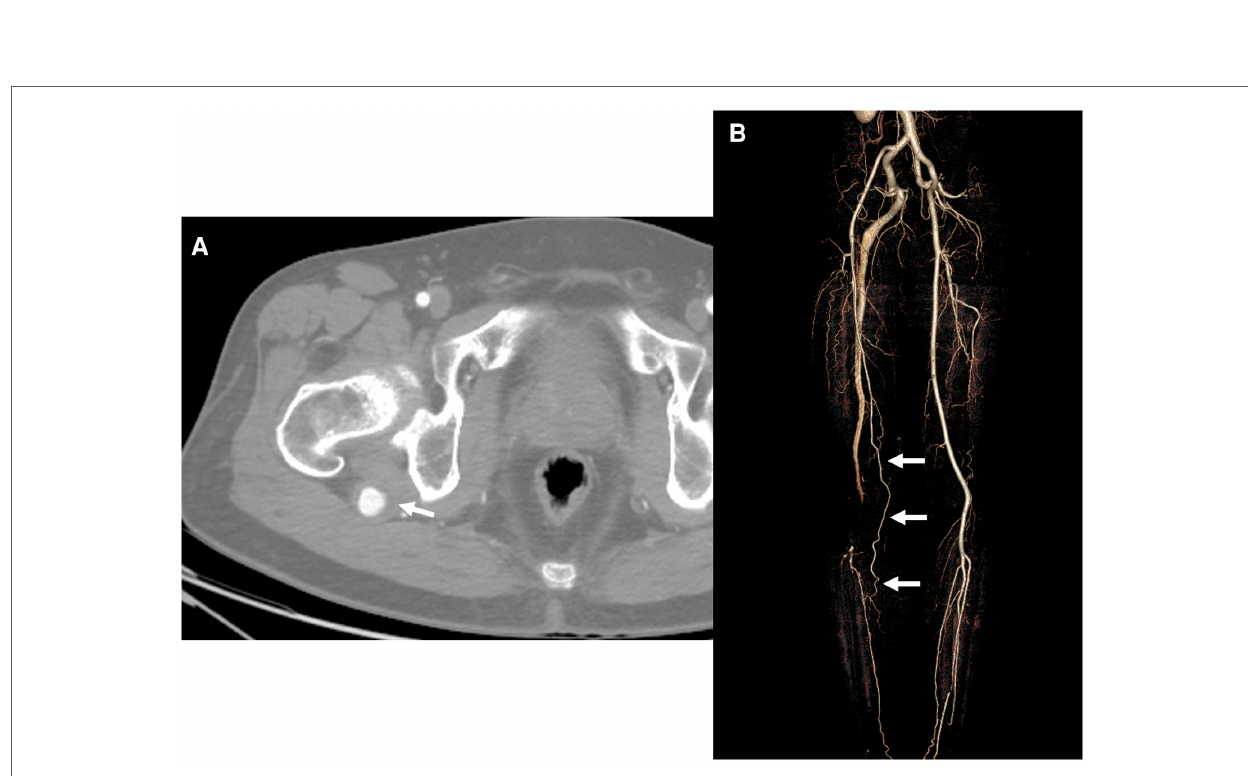
FIGURE 3 Initial computed tomography angiography (CTA) of the second case. ( A ) Axial image of the CTA revealed an aneurysm with a diameter of 22 m and a mural thrombus of the persistent sciatic artery (PSA) ( arrow ) at the posterior aspect of the greater trochanter of the femur. ( B ) Three-dimensional reconstruction image revealed a collateral fl ow (arrows) to the calf and foot from the incomplete super fi cial femoral artery and occluded distal popliteal artery connected with the PSA.